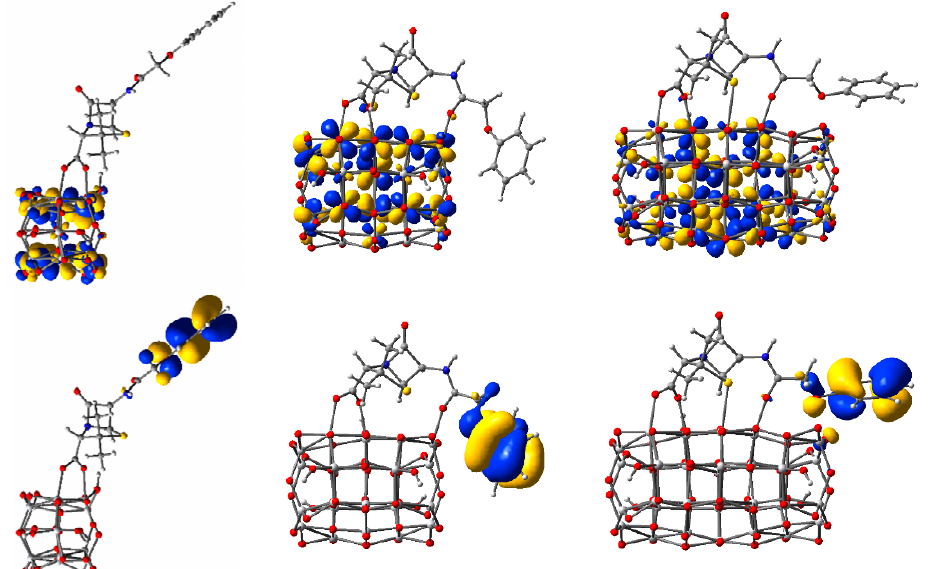
Figure 19. Isodensity surfaces (0.03 e/bohr 3 ) of the key molecular orbitals of the systems consisting of the PV molecule adsorbed on the Ti n O 2 n +2 H 4 cluster ( n = 14, left; n = 24, middle; and n = 34, right column), calculated by DFT at the B3LYP/LANL2DZ level in water solvent. The first row displays the LUMOs, whereas the bottom row shows the HOMOs. Atom colors: Ti, light grey; C, grey; O, red; N, blue; S, Yellow; and H, very light grey.